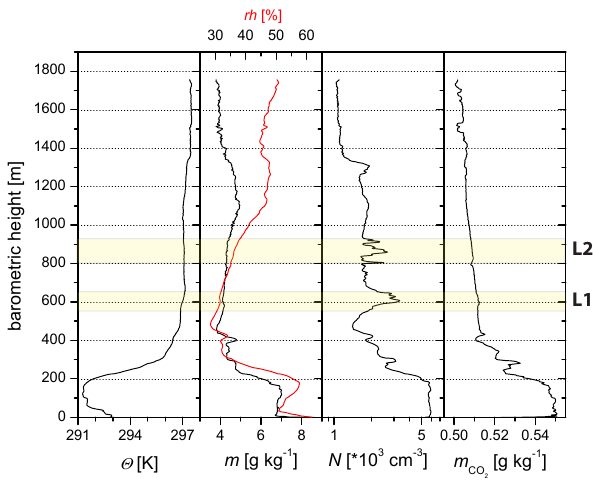
Fig. 3. Vertical profiles of potential temperature 2 , relative humid- ity rh , water vapor mixing ratio m , particle number concentration N , and mixing ratio of CO 2 . This profile was measured during the first ascent after take-off (profile 1) on 13 May 2008. Shaded regions L1 and L2 indicate layers with enhanced particle number concentration.